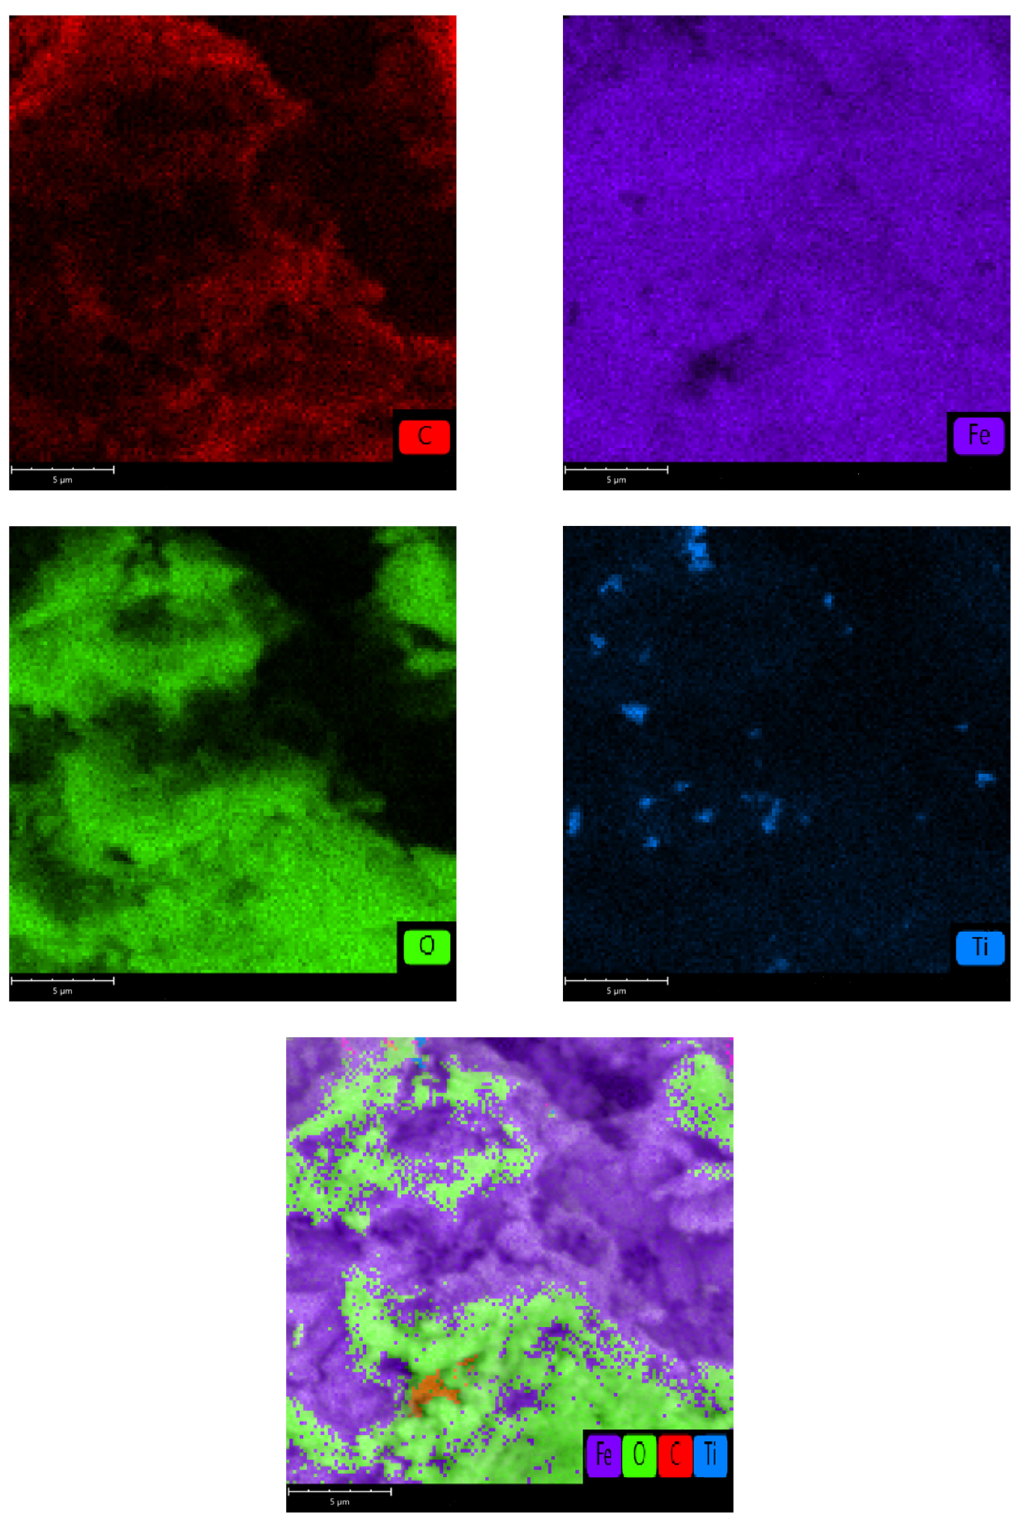
Figure 5: Elemental mapping pro fi le of Fe 3 O 4 /TiO 2